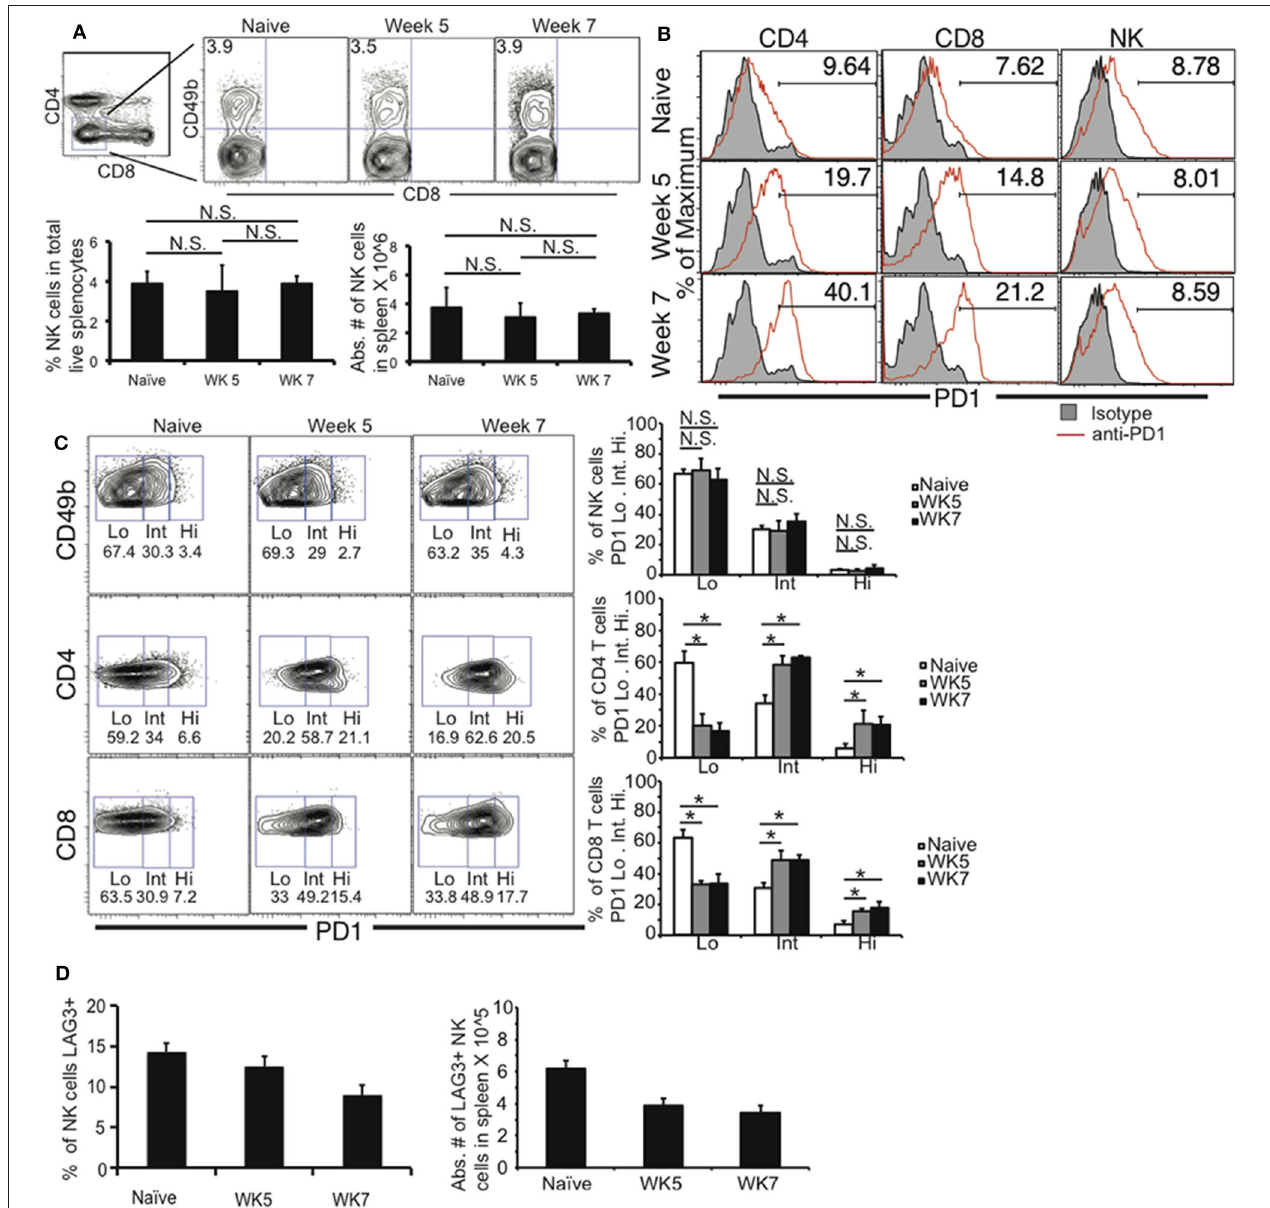
FIGURE 1 | NK cells do not exhibit immune exhaustion characteristics during chronic T. gondii infection. C57BL/6 mice were orally infected or not with 10 cysts of ME49 and 5 and 7 weeks after infection spleen cells were analyzed for (A) NK cell (Lineage-CD49b + ) frequency and number. NK cells, CD4 + and CD8 + T cells were then analyzed for (B) PD1 MFI and (C) PD1 + frequency based on separating the populations into PD1 low (Lo), intermediate (Int), and high (Hi). NK cells were then assayed for (D) LAG3 expression. Raw flow data presented are representative and based on means from 3 independent experiments. All graphs are mean ± SD. Graphs present pooled data from 2 independent experiments. Significance is denoted by *with a p ≤ 0.05, n = 4–5 mice per group.